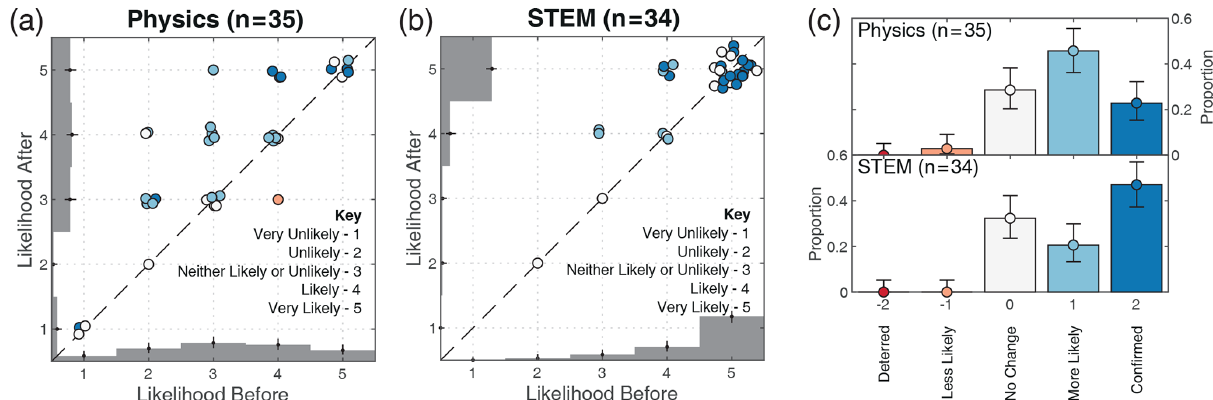
Figure 3. Likelihood before and after of PRiSE students continuing with (a) physics and (b) STEM education. Data points have been jittered for visibility. Marginal distributions (grey areas) are also shown for both before and after. How PRiSE specifically has affected students’ aspirations is shown in (c) for physics (top) and STEM (bottom), where the colours used are also reflected in (a) and (b) . Error bars denote the standard (1 σ ) Clopper and Pearson (1934)